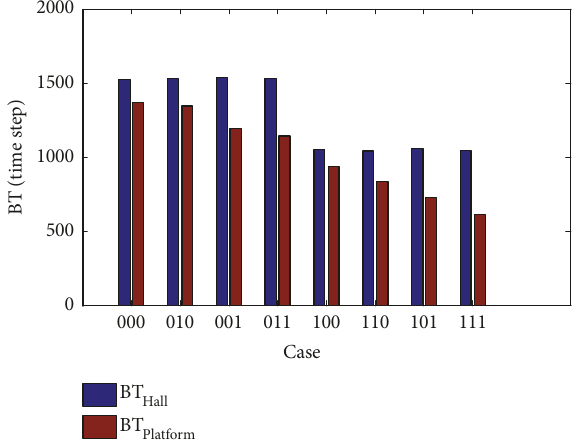
Figure 7: 𝐵𝑇 Hall and 𝐵𝑇 Platform under the eight